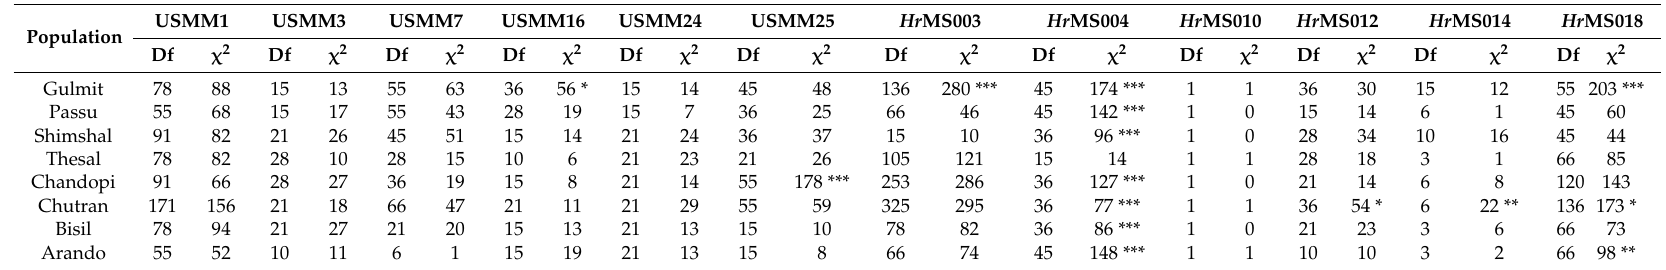
Table 5. Summary of χ 2 -tests for Hardy-Weinberg equilibrium per population and microsatellite locus in sea buckthorn accessions of the Gilgit and Baltistan regions, northern